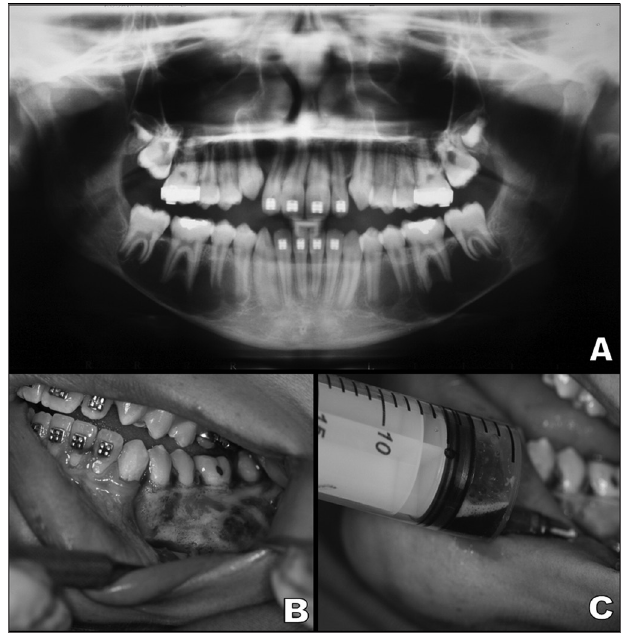
Figura 1. A: Radiografia panorâmica mostrando uma lesão multilocular bilateral com festonamento ao longo das raízes dentárias na região posterior da mandíbula. B: Visão intraoral após realização de retalho mucoperiosteal mostrando expansão óssea com aparência hemorrágica. C: Punção aspirativa mostrando a presença de líquido